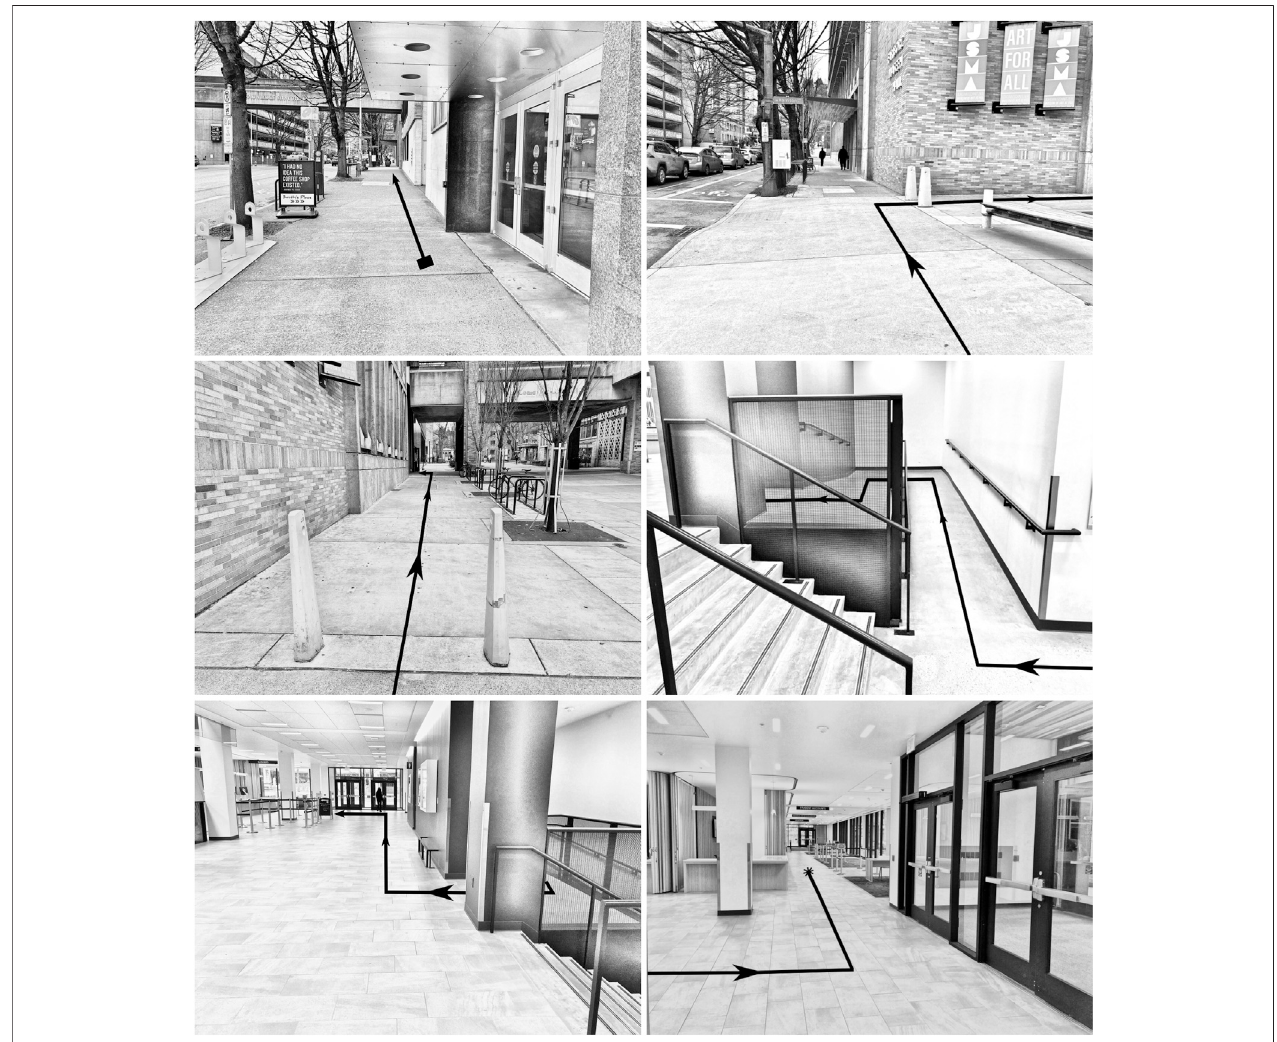
FIGURE 4 | Sequence of photos (top to bottom, left to right) illustrating the conceptualized course of Route A from its origin at the entrance of Smith Memorial Student Union to its destination at the Student Accounts desk in the Fariborz Maseeh Hall building.